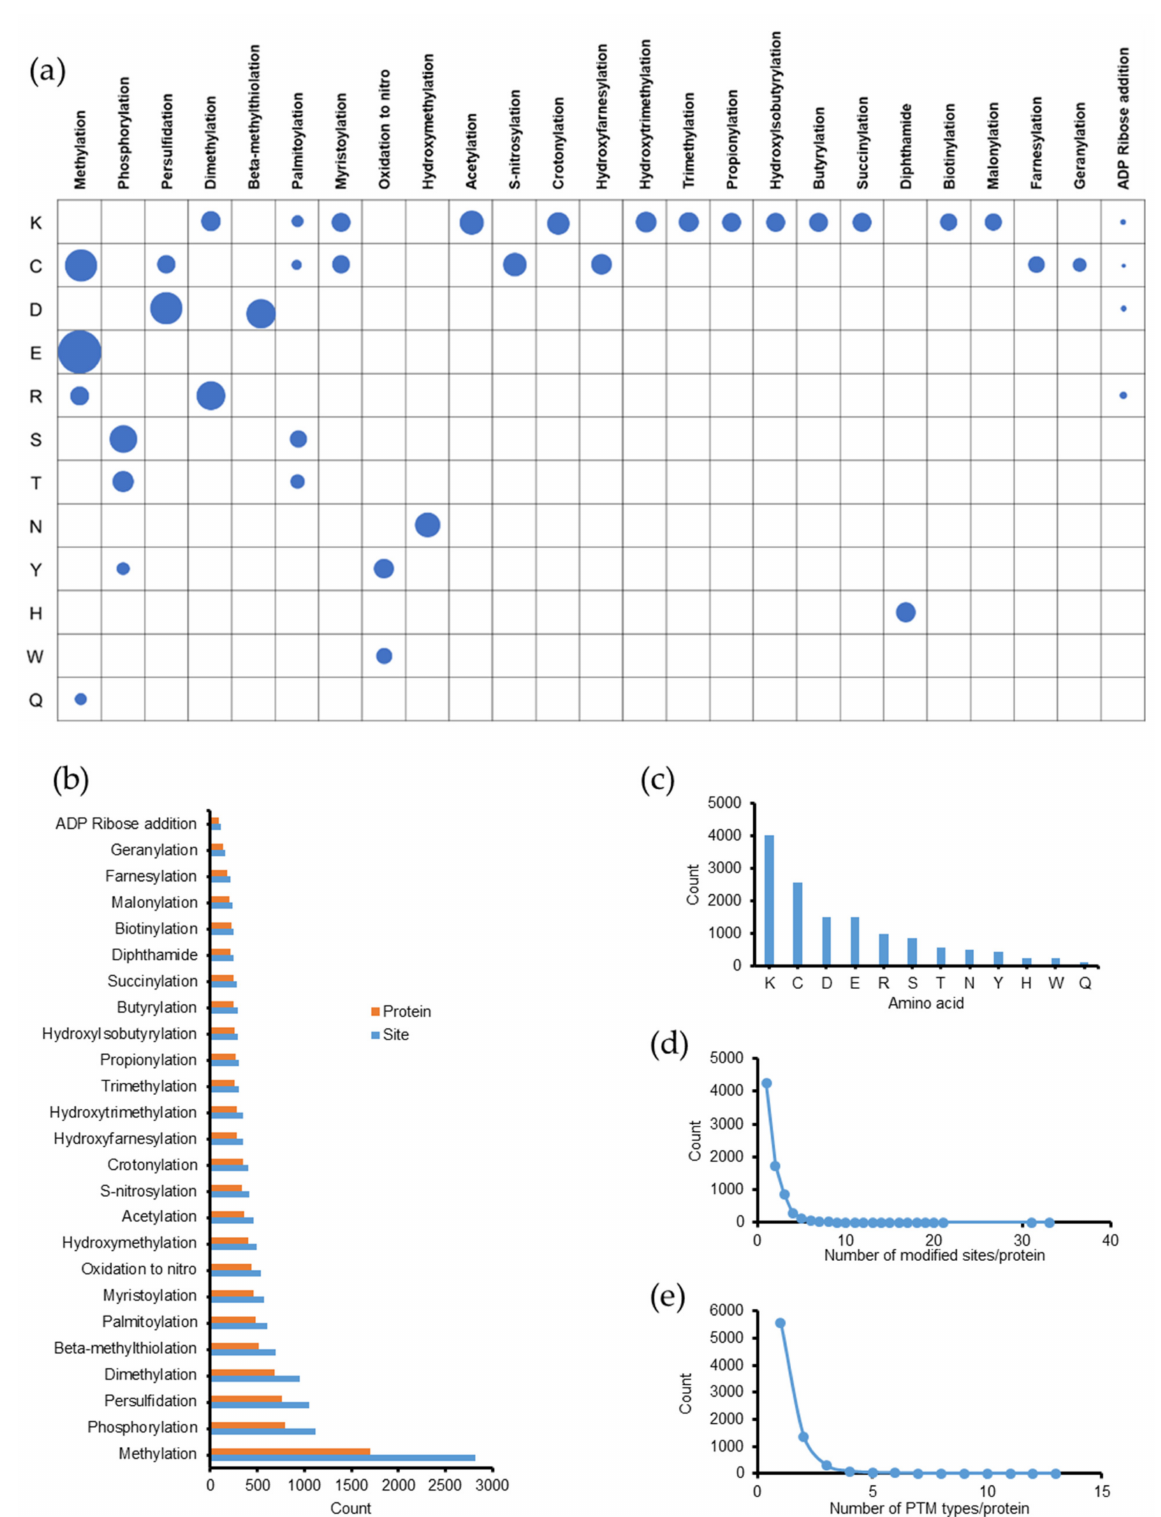
Figure 1. Global discovery of post-translational modifications (PTMs) in Emiliania huxleyi from tandem mass (MS/MS) spec- tra. ( a ) PTM distribution by PTM types and amino acid sites. The number of modified sites is proportional to the area of the circle. ( b ) The number of modified sites and proteins according to each type of PTM. K: lysine, C: cysteine, D: as- partic acid, E: glutamic acid, R: arginine, S: serine, T: threonine, N: asparagine, Y: tyrosine, H: histidine, W: tryptophan, and Q: glutamine. ( c ) The number of PTMs by amino acids. ( d , e ) The number of modified sites and PTM types in each